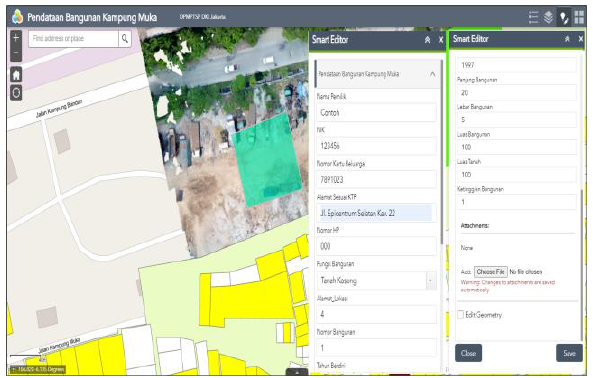
Figure 9 . Smart editor interface of attributes filling